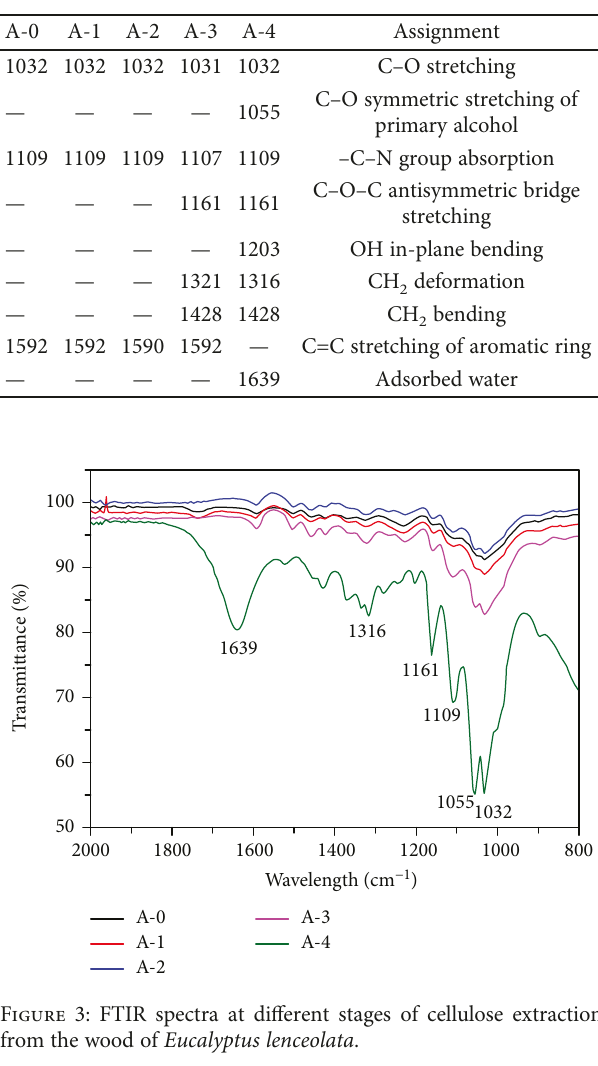
Table 2: Assignment of infrared adsorption bands of the samples in various wavelengths (cm − 1 ).